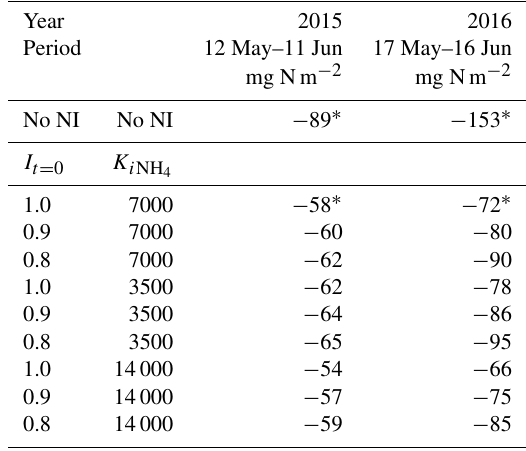
Table 9. Sensitivity of seasonal N 2 O emissions modelled during late spring in 2015 and 2016 to changes in initial inhibition ( I t = 0 in Eq. 1) and inhibition constant ( K i NH in Eq. 2) following spring 4 slurry application on dates in the field study (Table 3). Negative values denote